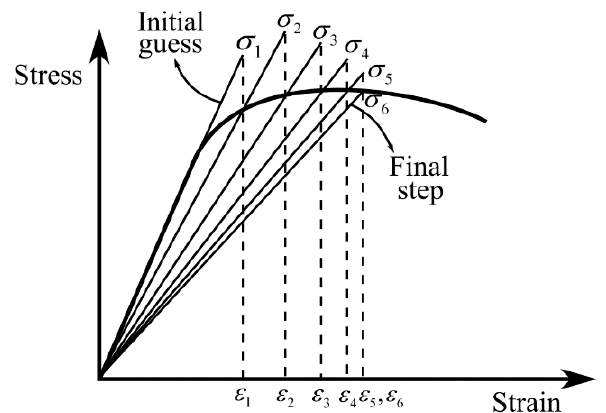
Figure 4. Direct iteration procedure.